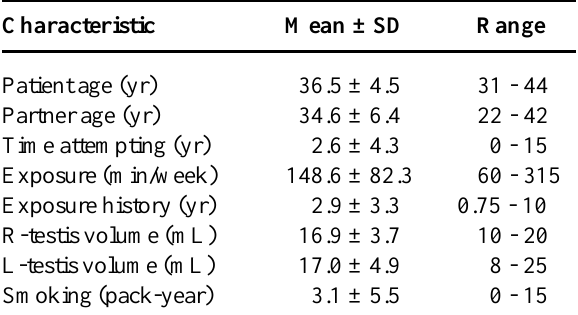
Table 1 – Characteristics of the study group.